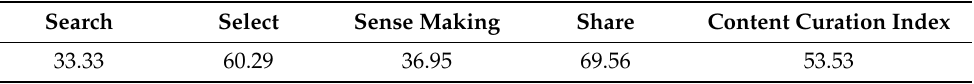
Table 4. Content curation index and mean scores obtained in each step of the content curation process.